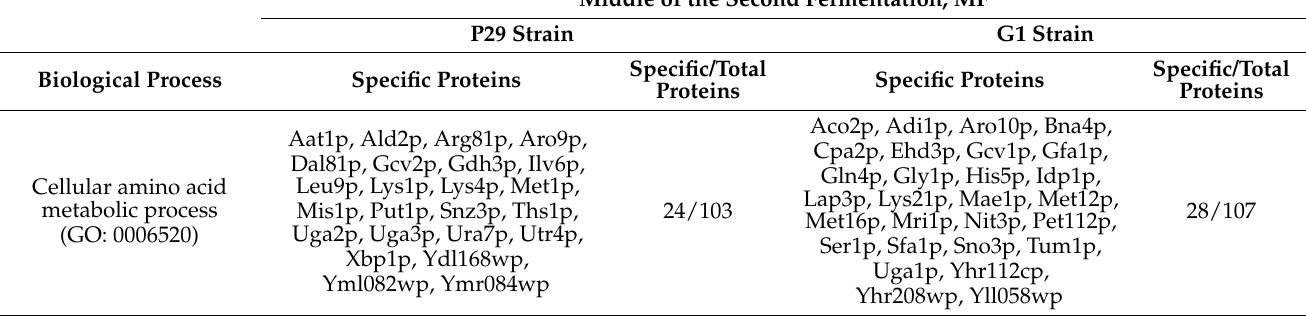
Table 1. Biological processes, specific proteins, and ratio of specific to the total proteins related to amino acid metabolism in S. cerevisiae P29 and G1 during two sampling times, at the middle of the second fermentation (MF) and at the end of the second fermentation